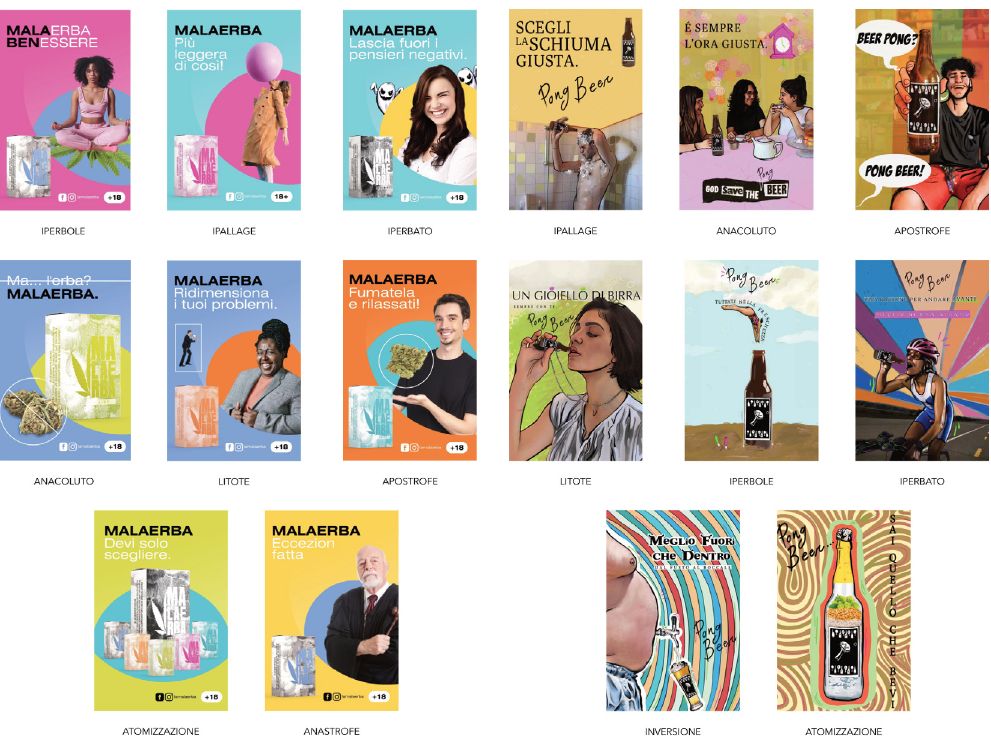
Figs. 6a, 6b Transformation Figures. The group